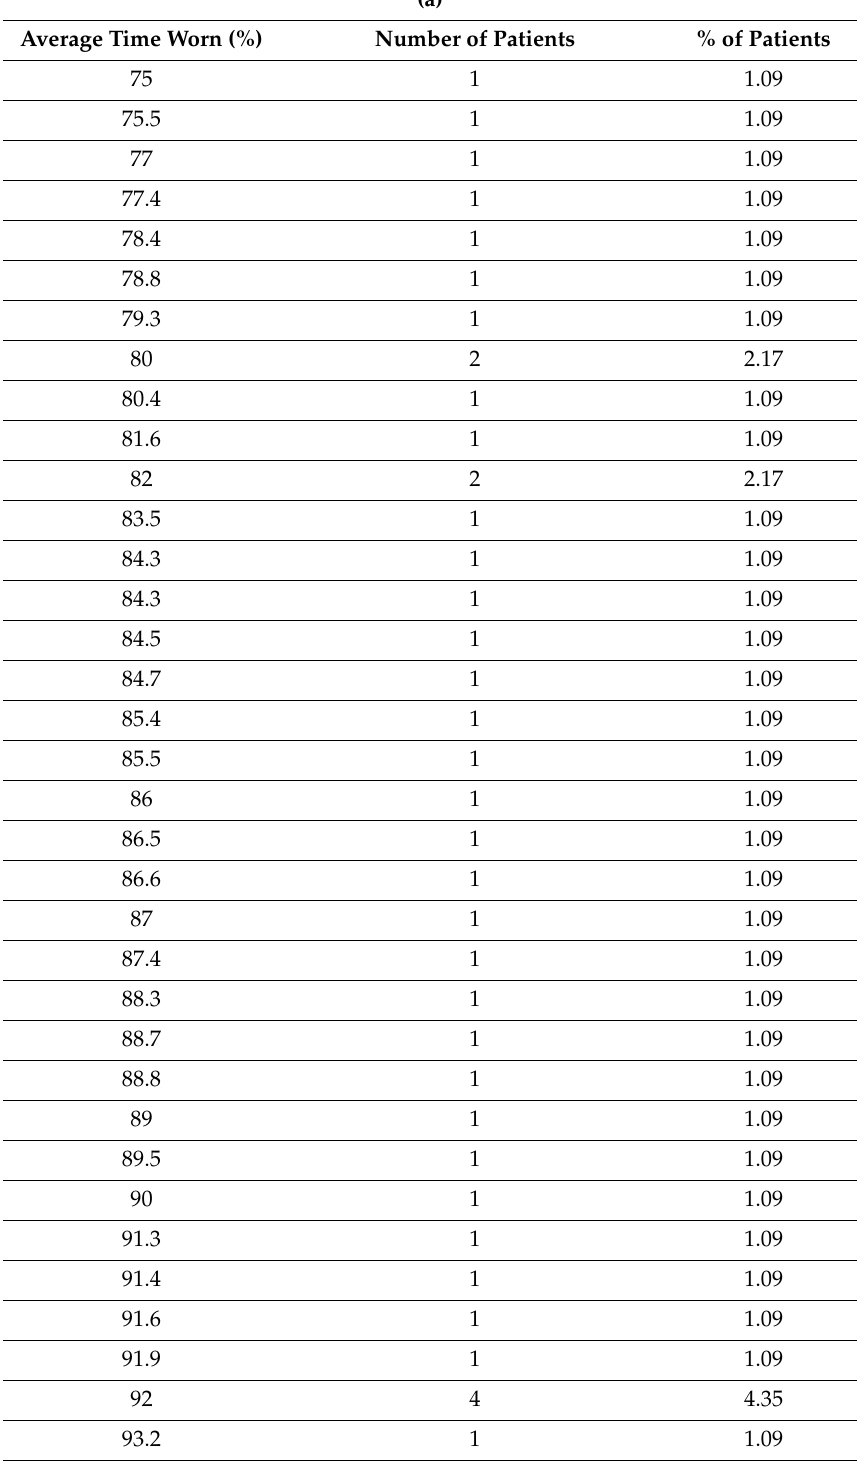
Table A3. ( a ) Patients who had a wear time ≥ 75% ( n = 70). ( b ) Di ff erences between patients with ≥ 75% wear time and < 75% wear time. Simple t-test and chi 2 tests were performed to determine a p